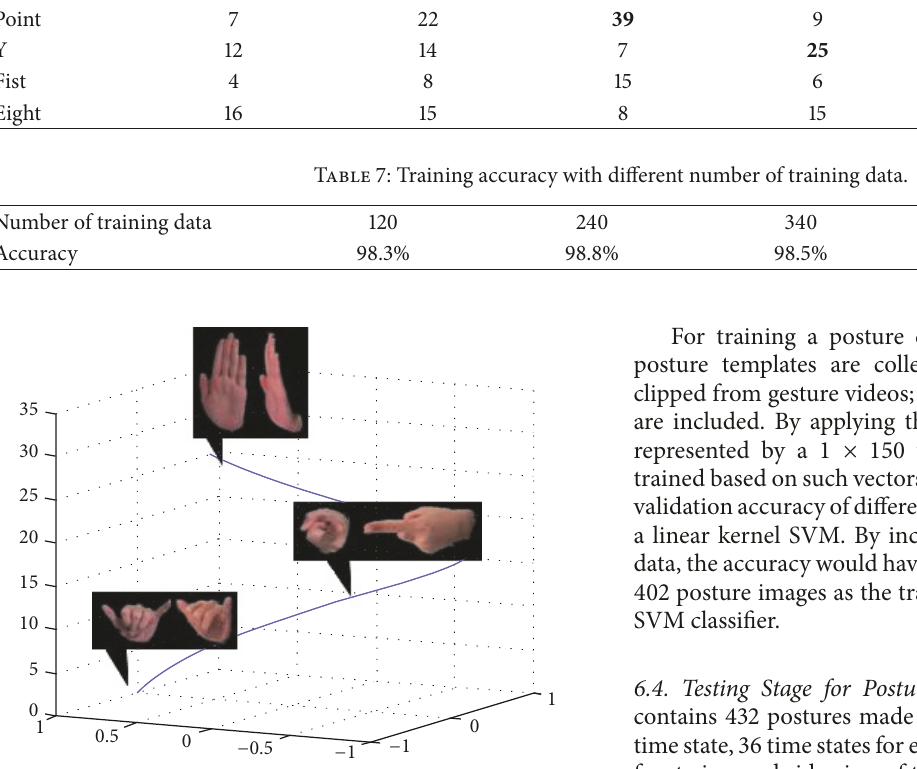
Figure 18: Hand posture is changing along the trajectory, and the hand posture is captured by both